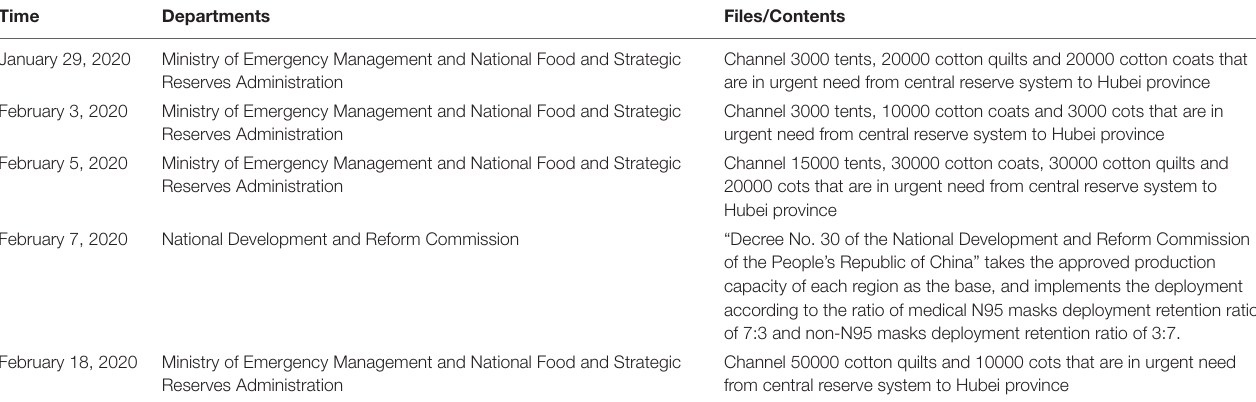
TABLE 3 | Allocation of anti-epidemic materials.